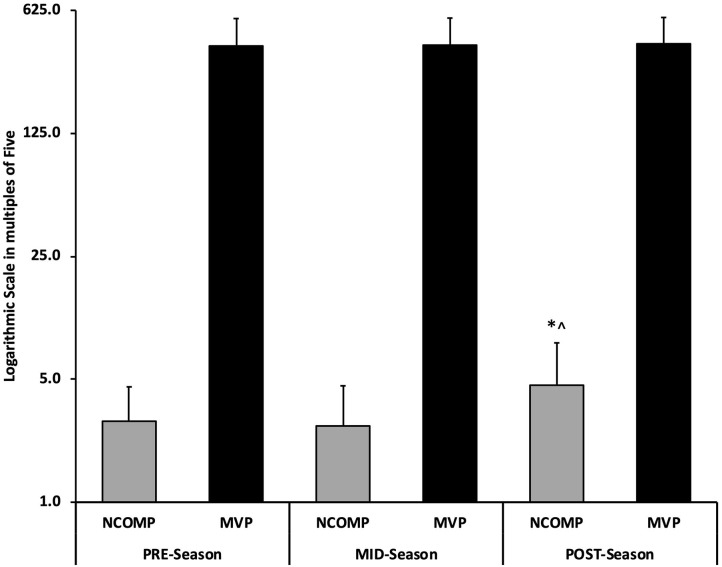
Relationship between maximal vertical power (MVP) expressed in watts (W) and NCOMP left/right difference expressed as an (absolute value) across the competitive season (PRE, MID, POST time blocks). (NCOMP) normalized composite score, NCOMP = [(ANT+PTL+PTM/(leg length*3)]*100. (*) indicates a statistically significant change from MID season (p < 0.05). (∧) left/right NCOMP difference exceeds 4.0 indicating a 6.5x increase in injury risk (Plisky et al., 2006; Gonell et al., 2015; Stiffler et al., 2017).